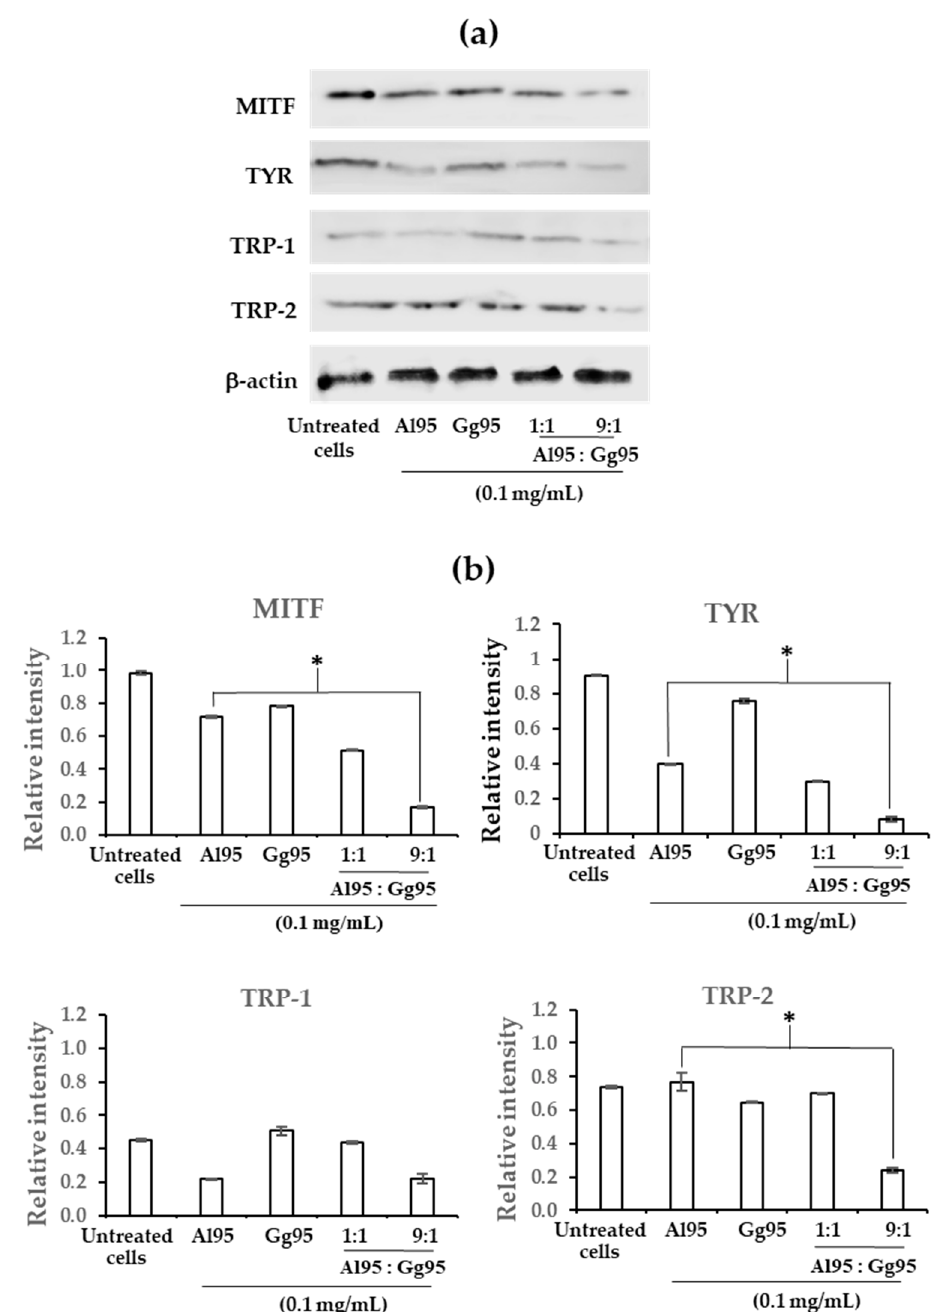
Figure 6. Inhibitory e ff ect of combined A. lakoocha and G. glabra extracts on proteins related to melanogenesis. ( a ) Protein bands for microphthalmia-associated transcription factor (MITF), tyrosinase (TYR), tyrosinase-related protein (TRP)-1, TRP-2 and β -actin. ( b ) Relative intensity of protein levels of MITF, TYR, TRP-1, and TRP-2. Cells were treated with mixtures of Al95 and Gg95 at final concentration of 0.1 mg / mL at ratios of 1:1 and 9:1 for 48 h. The samples derive from the same experiment and blots were processed in parallel. The data are means ± SD from three independent experiments. The superscript letters (*) indicate significant difference at p < 0.01.